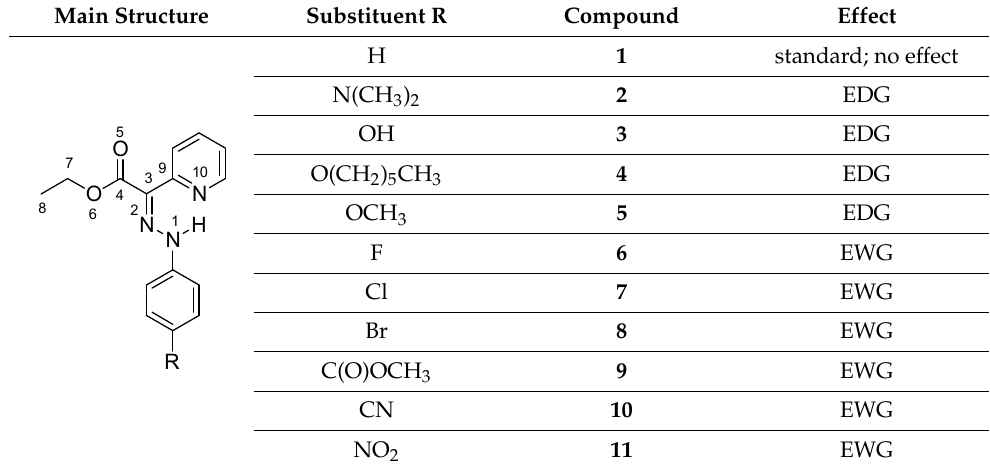
Table 2. Para -substituted phenylhydrazones and substituent effects on the aromatic ring. Main Structure